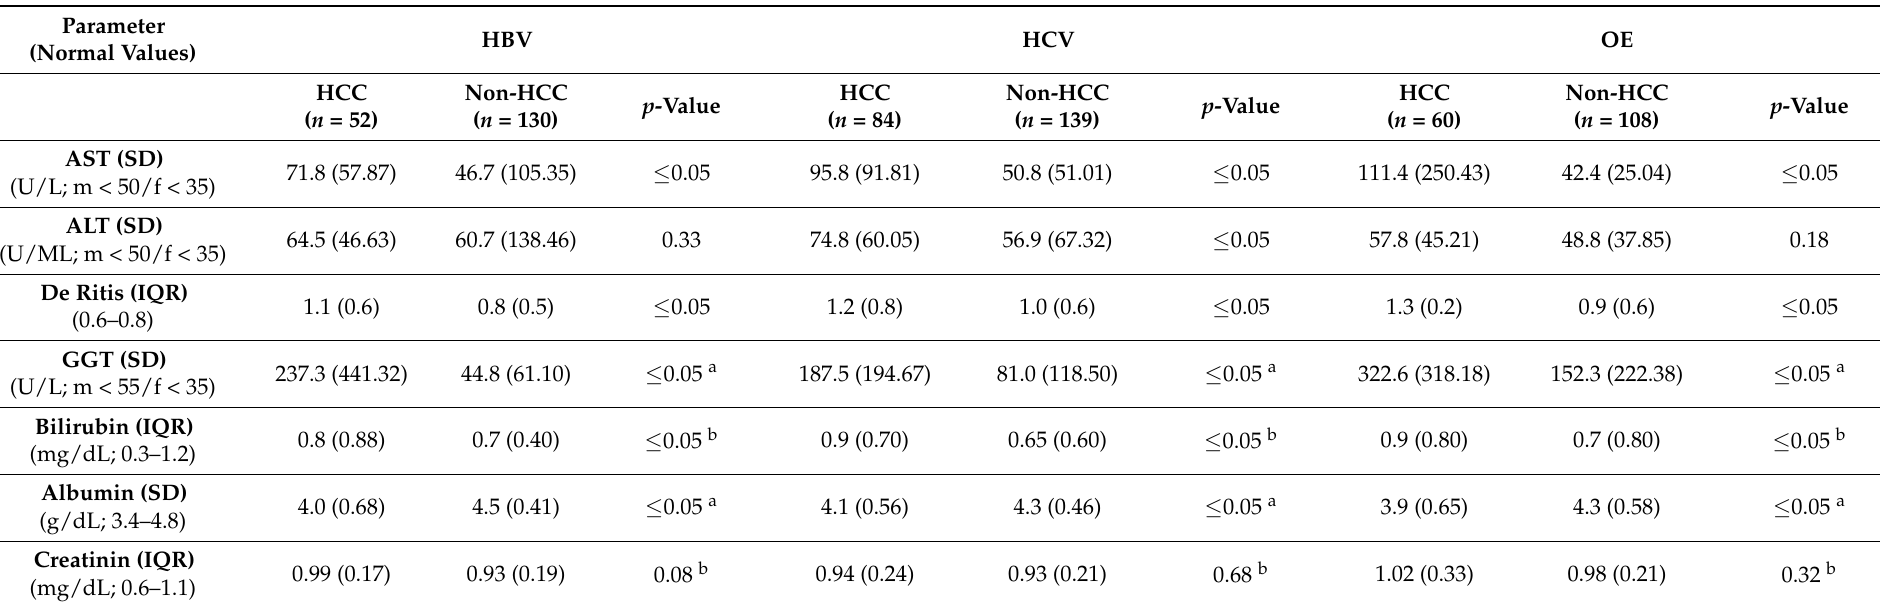
Table 2. Lab values of HCC group and control group for HBV, HCV and